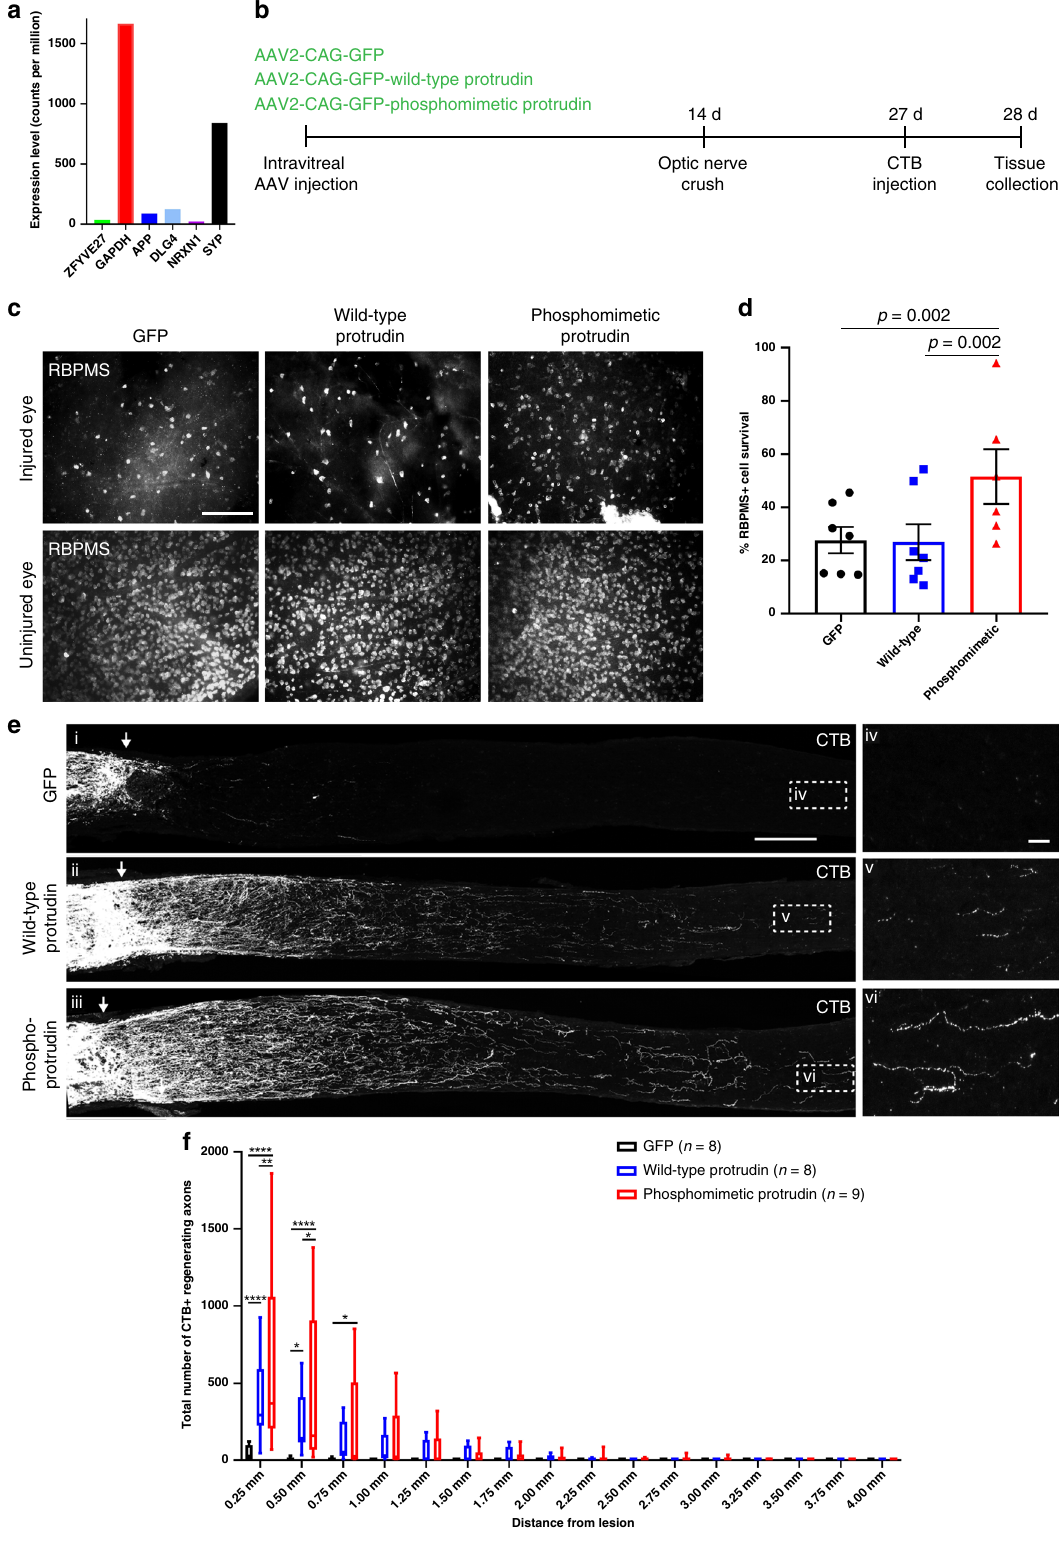
membrane traf fi cking events 43 . In addition, based on the original hypothesis, the domain ’ s linking axonal transport to membrane and endosomal traf fi cking (FYVE domain, KIF5/VAPA domain and RBD) were mutated, and each of these changes suppressed the axon regeneration-promoting effect of Protrudin (Fig. 3e,